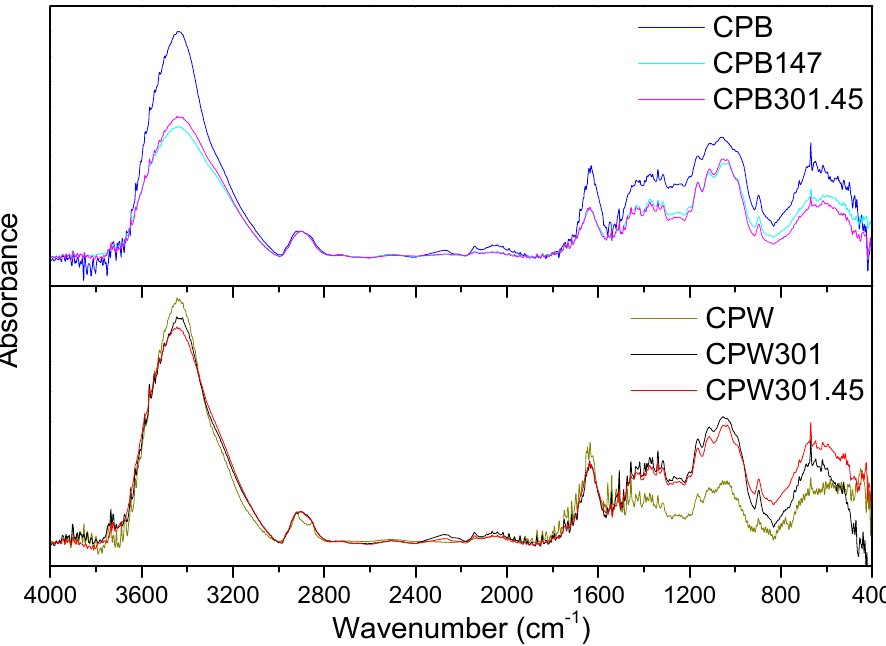
Figure 3. Fourier transform infrared (FTIR) spectra of ( top ) barley- and ( bottom ) wheat-straw-based pulps.